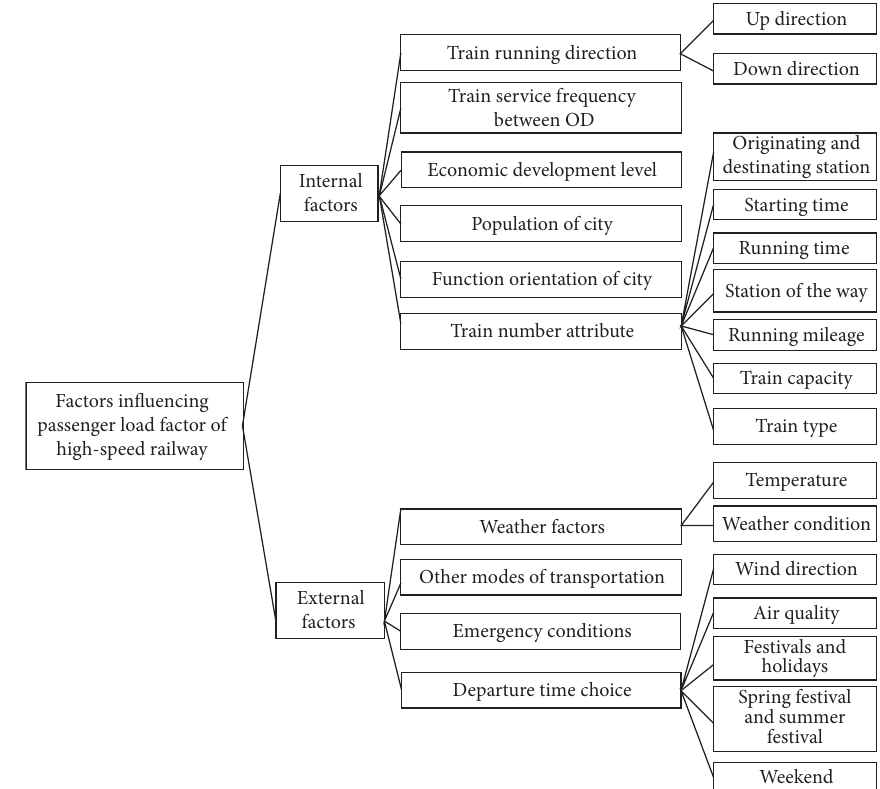
Figure 1: Influencing factors of train passenger load